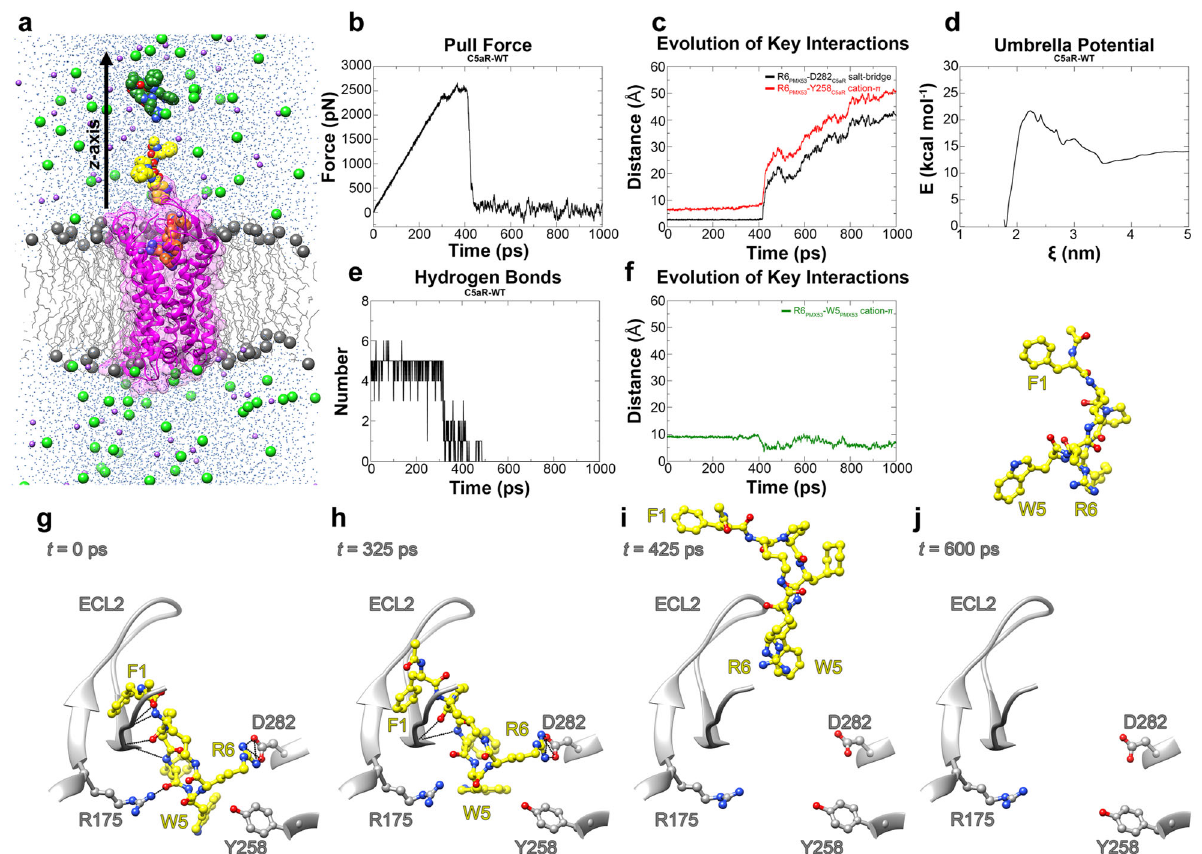
Fig. 4 Steered molecular dynamics (SMD) or center-of-mass (COM) pulling simulation of C5aR (WT) – PMX53 complex. a Cut-through section of C5aR (WT) – PMX53 – POPC system used for equilibrium MD and steered MD simulations. C5aR is shown in ribbon representation (magenta), embedded in a POPC bilayer (gray) with the headgroup phosphorous atoms shown in sphere representation and the rest of the lipid molecules shown in wire representation. TIP3P water molecules are colored blue, Na + ions purple, and Cl − ions green. Positions and conformations of PMX53 at t = 0 ps, t = 500 ps, and t = 1000ps derived from the COM pulling simulation are shown in orange, yellow, and dark green colors, respectively. The black arrow is along the z -axis and indicates the direction of pulling of PMX53. b Plot showing force (pN) vs. time (ps) pro fi le obtained for the C5aR (WT) – PMX53 system with a pulling rate of 5nm ns − 1 . c Evolution of key intermolecular interactions between C5aR (WT) and PMX53, namely the R6PMX53 – D282C5aR salt-bridge (black), and the R6PMX53 – Y258C5aR cation- π interaction (red) over the course of the pulling simulation. d Potential of mean force pro fi le calculated for the dissociation of PMX53 from C5aR (WT) using WHAM following umbrella sampling simulations for the C5aR (WT) – PMX53 system. The average PMF pro fi le calculated using bootstrap analysis is presented in the Supplementary Fig. S6f. e Plot showing the number of intermolecular hydrogen bonds (H bonds) formed/broken between the ECL2 region (residues 174 – 196) of C5aR (WT) and PMX53 over the course of the pulling simulation. f Evolution of key intramolecular interaction R6PMX53 – W5PMX53 cation- π interaction (green) in PMX53 over the course of the pulling simulation. g Position and conformation of PMX53 at t = 0 ps during pulling simulation (pull force = 7.62× 10 − 5 pN) where R6PMX53 stably and directly interacts with D282C5aR as compared to the conformation observed in the starting crystal structure conformation. In this conformation, PMX53 forms extensive H bond interactions (shown as black lines) with the residues of C5aR (WT), especially with residues of ECL2. h Position and conformation of PMX53 at t = 325ps during pulling simulation (pull force = 2386.14pN) where key non-covalent interactions between PMX53 and C5aR (WT) begin to break and R6PMX53 and W5PMX53 are being pulled away from Y258C5aR and D282C5aR. A number of HBonds between PMX53 and ECL2 also as broken or are in the process of being broken under the in fl uence of the applied force. i Position and conformation of PMX53 at t = 425ps during pulling simulation (pull force = 879.08 pN) where the PMX53 molecule has been pulled further away with the R6PMX53 – D282C5aR salt-bridge and the R6PMX53 – Y258C5aR cation- π interaction being completely broken. j Position and conformation of PMX53 at t = 600ps during pulling simulation (pull force = 29.48pN) where the ligand is completely unbound from the